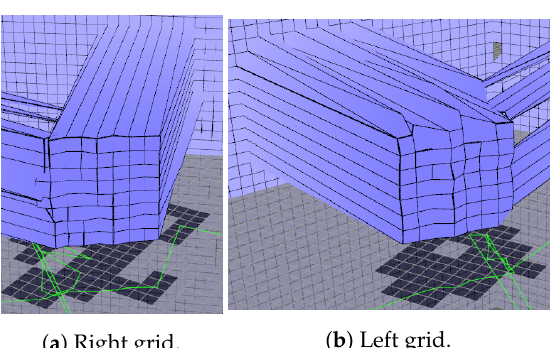
Figure 19. The box represented on the local map when seen by the right ( a ) and left ( b )